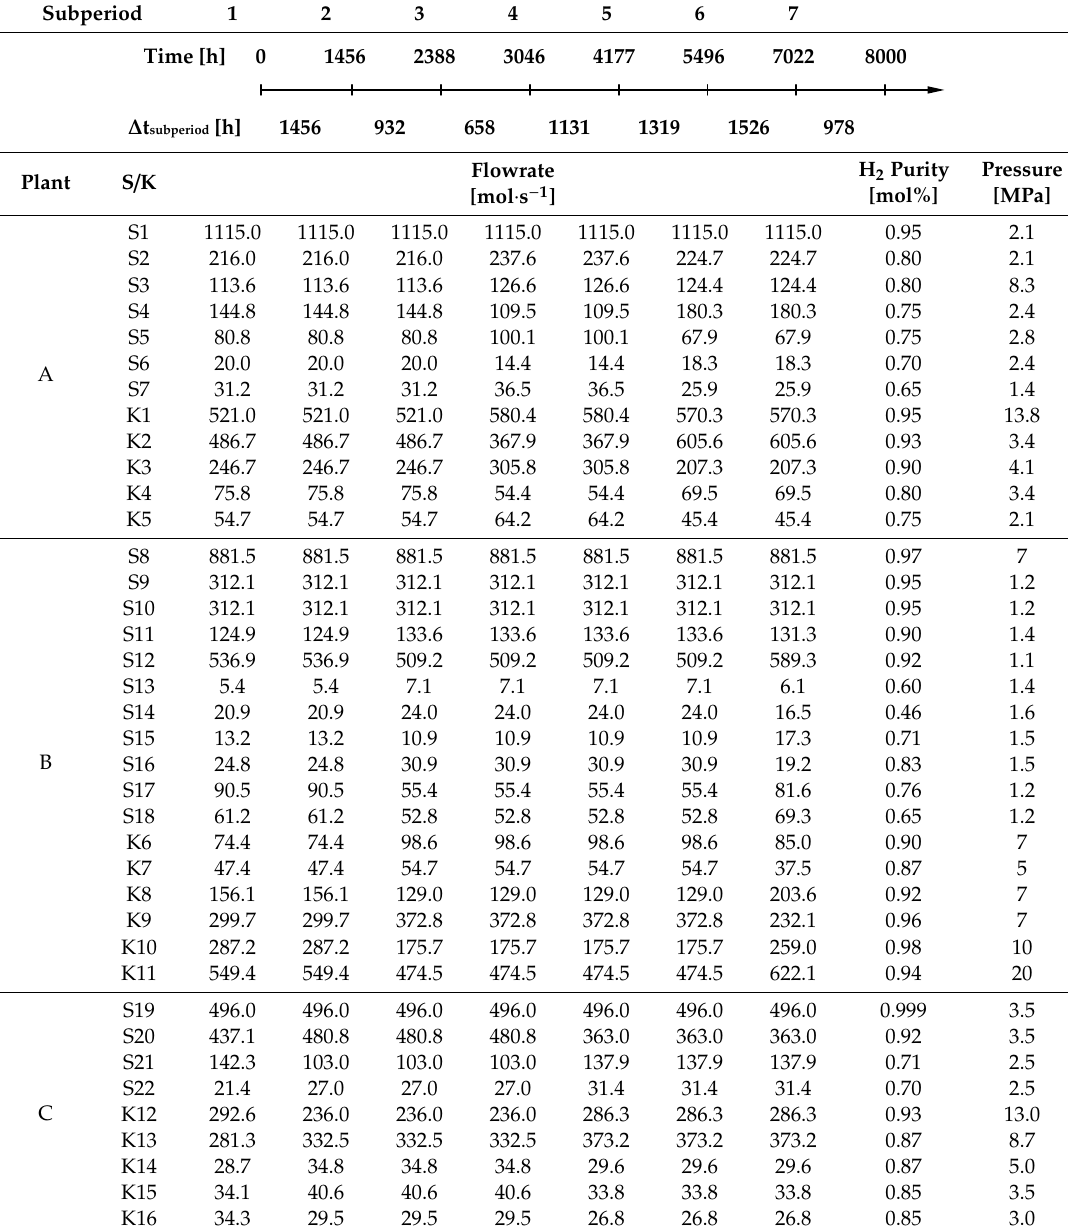
Table 1. Subperiod partitioning of the inter-plant hydrogen network and parameters of hydrogen sources and hydrogen sinks.